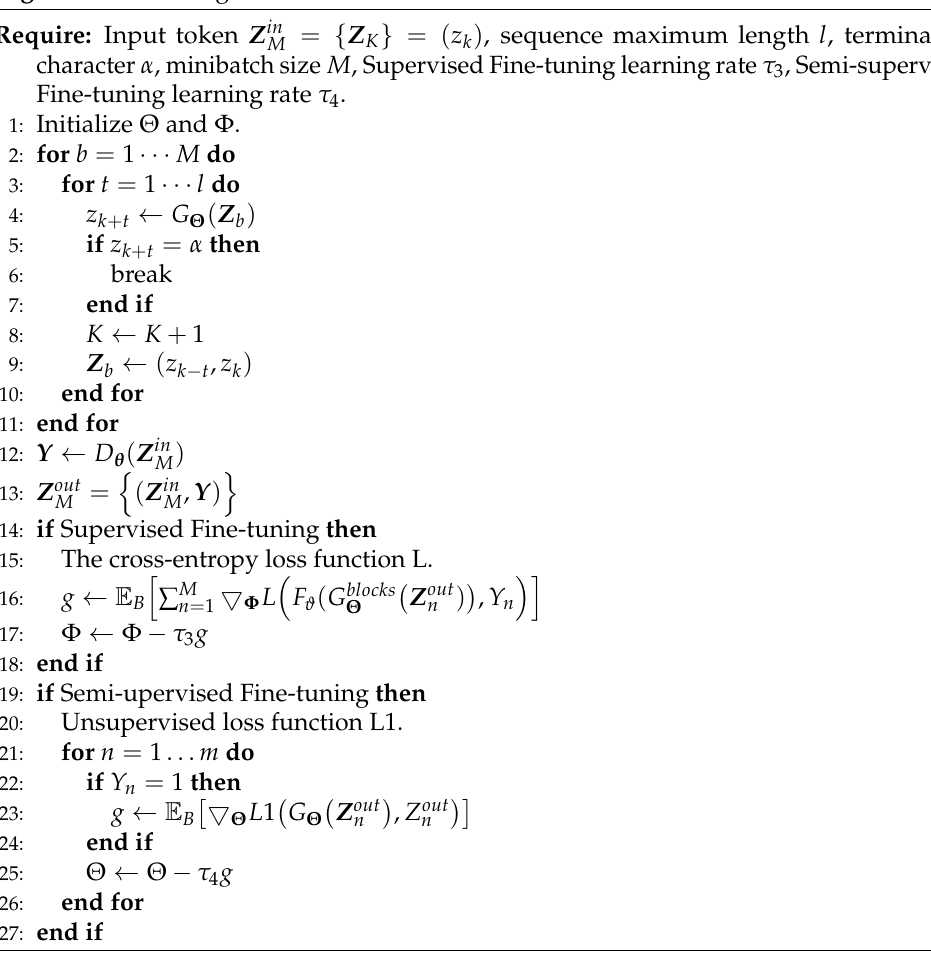
Algorithm 2 Training